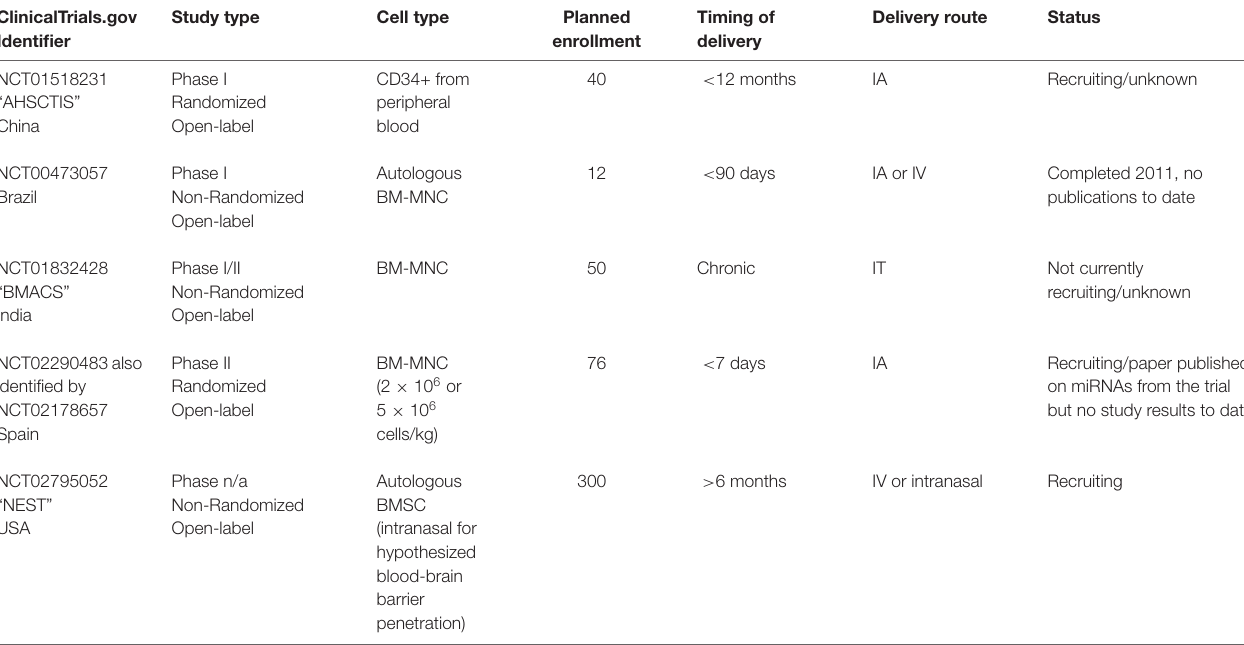
TABLE 3 | Ongoing and pending unpublished hematopoietic lineage